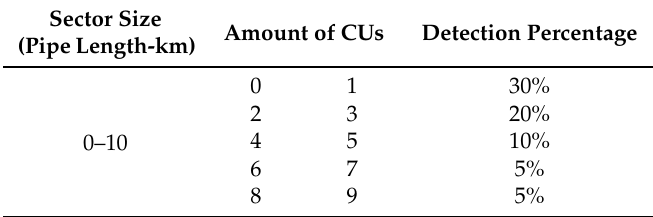
Table 1. Percentages of leakage event detection as a function of the sector size and